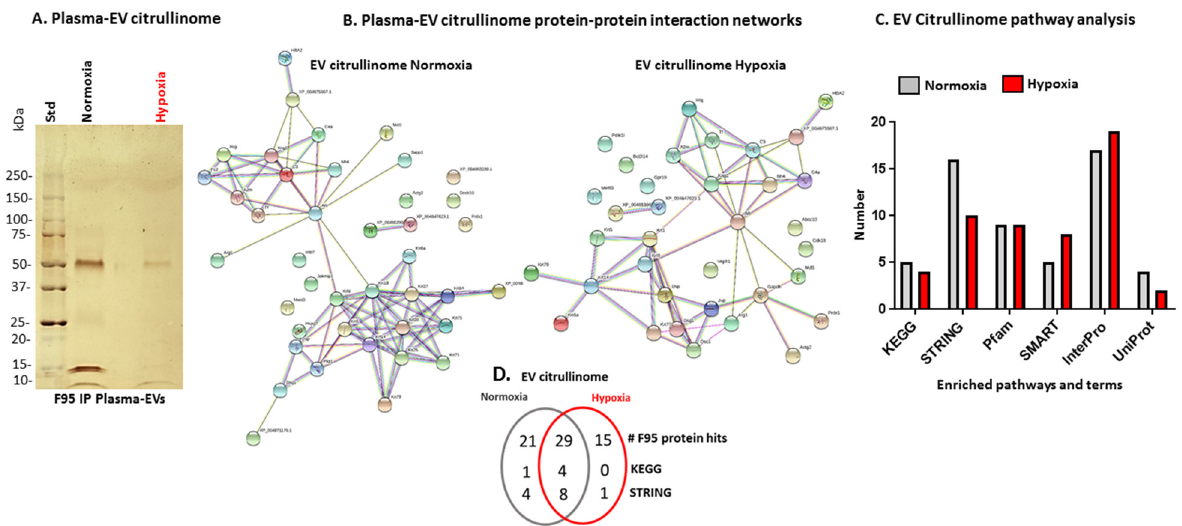
Figure 4. F95-enriched protein cargo of plasma EVs (EV citrullinome) from normoxia- and hypoxia- treated naked mole-rats. ( A ) SilverGel showing F95-enriched protein fractions from EVs (EV citrullinome) that were then subjected to LC-MS/MS analysis. ( B ) Protein–protein interaction networks created in STRING for the plasma-EV citrullinome of normoxia- and hypoxia-treated naked mole-rats. ( C ) Histogram showing number of pathway analysis terms associated with the EV citrullinome from normoxia- and hypoxia-treated animals. ( D ) Venn diagram summarising deimination/citrullination (F95) hits and main KEGG and STRING pathways related to these hits, indicating shared or distinct hits and pathways between the groups ( n = 5 animals per group). Table 3. F95-enriched proteins identified in plasma EVs from naked mole-rats treated under normoxic and hypoxic conditions, as assessed by LC-MS/MS analysis. Common and specific hits per group are indicated in the table; a tick (V) indicates whether the deiminated protein hit was identified in normoxia or hypoxia plasma EVs, or in both; blue highlighted rows indicate hits identified in the normoxia group only, and pink highlighted rows indicate hits identified in the hypoxia group